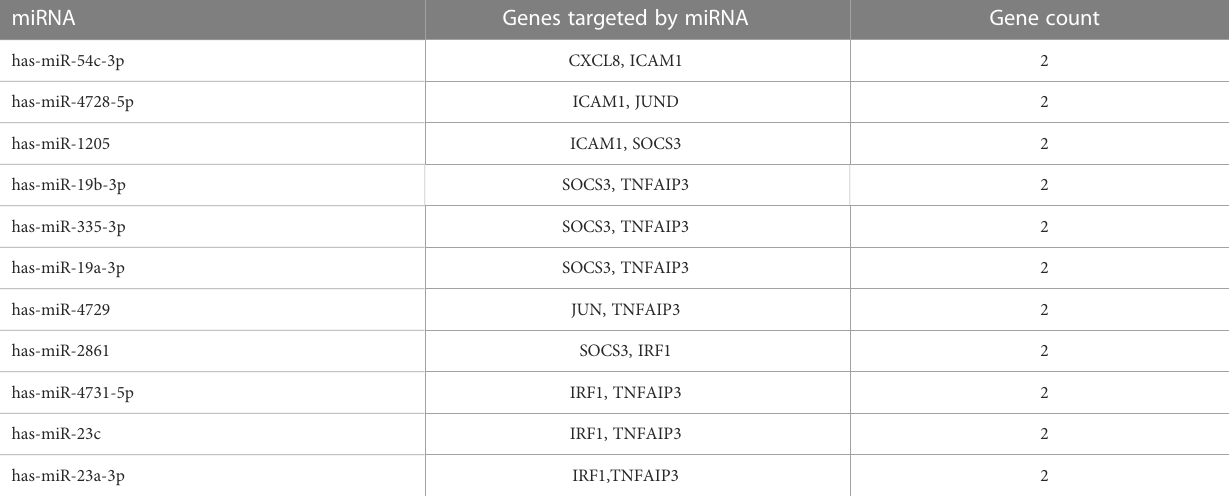
TABLE 4 miRNAs and its target